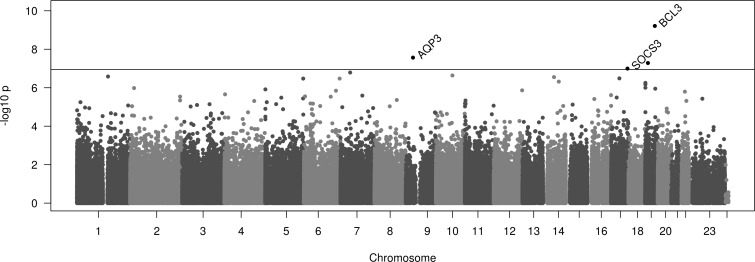
Manhattan Plot of the results of the genome-wide DNA methylation analysis on CRP conducted in the KORA F4 discovery sample.The Manhattan plot displays all analyzed CpG sites with their calculated p-values. Threshold of epigenome-wide significance: P = 1.13E-07.